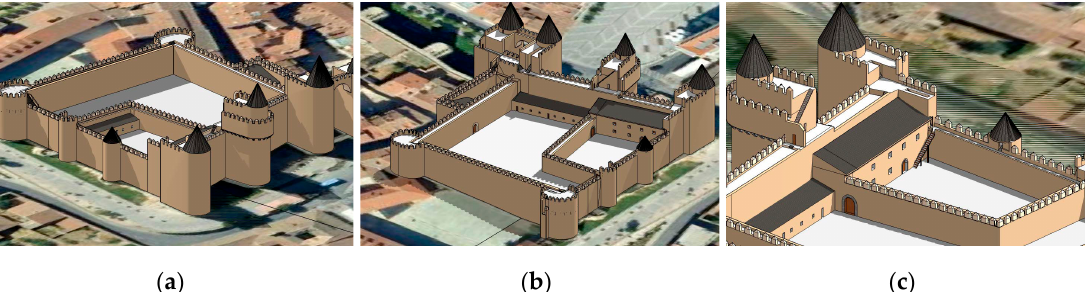
Figure 9. Intramural buildings: different views of the CAD (Computer-Aided Design) modeling of Alcázar previous to the mid-18 th century: ( a ) southeast view; ( b ) southwest view; ( c ) interior detail from the northwest viewpoint. [1].